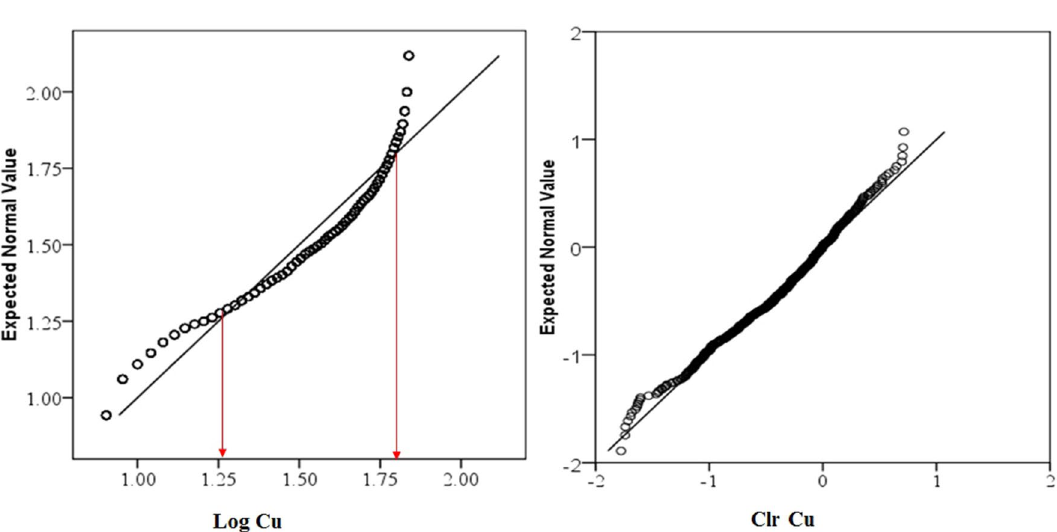
Figure 5. Q–Q PLOT of: (a) Cu original log-transformed data; (b) Cu clr-transformed